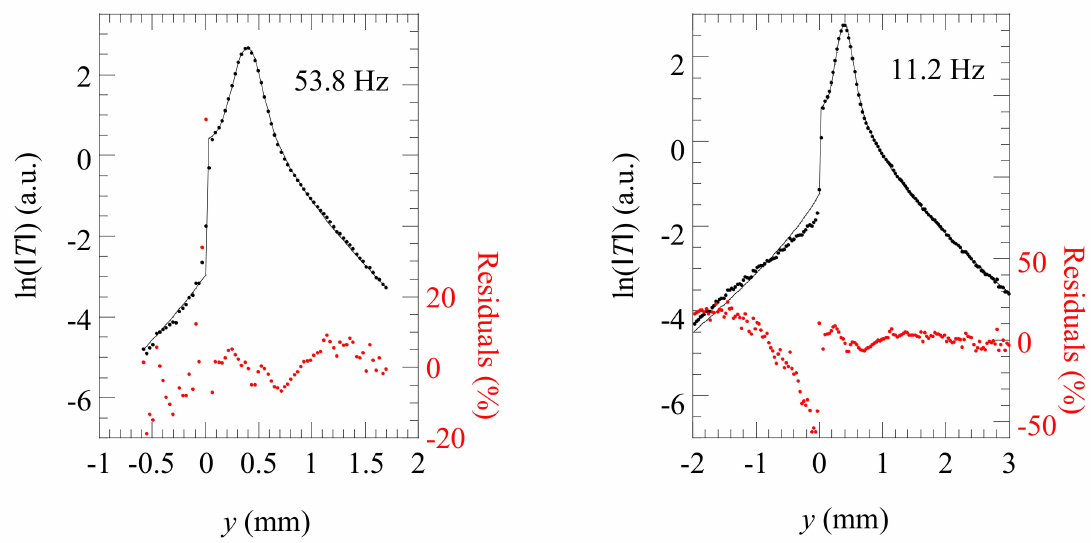
Figure 9. E xperimental ln(| T |) profiles corresponding to the left thermogram in Figure 7 for two modulation frequencies. Dots are the experimental results, and the continuous line is the fitting to Equation (2). Residuals are plotted to visualize the quality of the